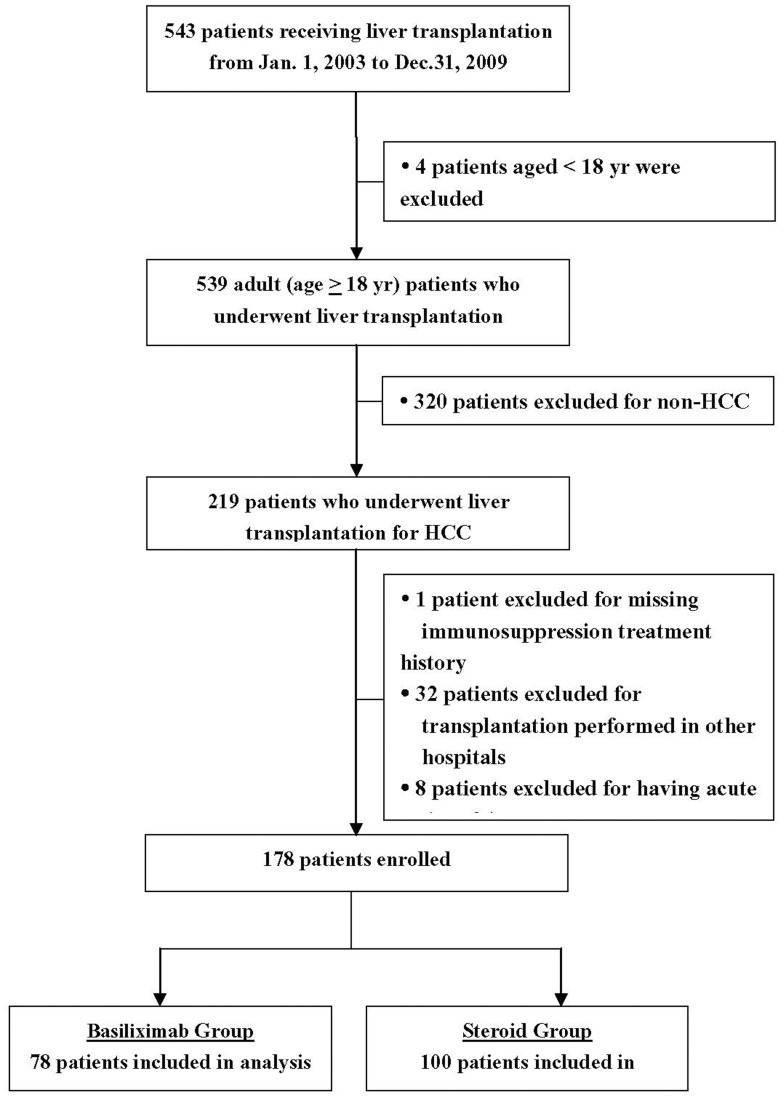
Consort diagram.